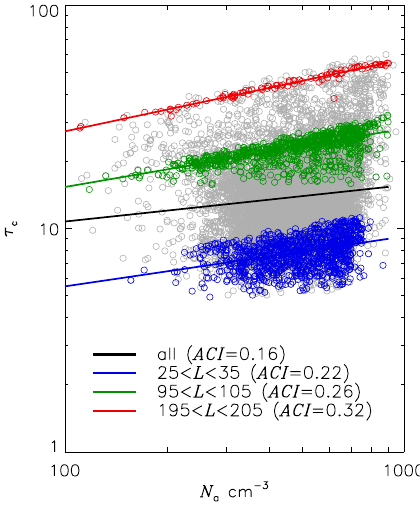
Fig. 11. Pairs of N a and τ c produced by a parcel model following the PDF sampling method in Fig. 5 using aerosol and cloud property inputs derived from the high resolution case of WRF scene “b” in Fig. 4. Grey symbols represent all data points from the modeled scene and colored symbols represent selected 10gm − 2 L bins. The black line represents the unconstrained slope or ACI resulting from all data points and the colored lines represent the slopes for that L bin, or selected constrained ACI